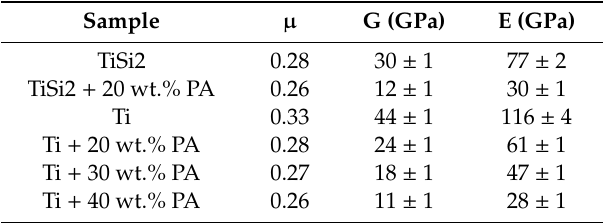
Figure 8. Fracture surface of alloys: ( a ) TiSi2; ( b ) Ti; ( c ) Ti + 20 wt.% PA. Table 3. Mechanical properties of studied alloys obtained by impulse